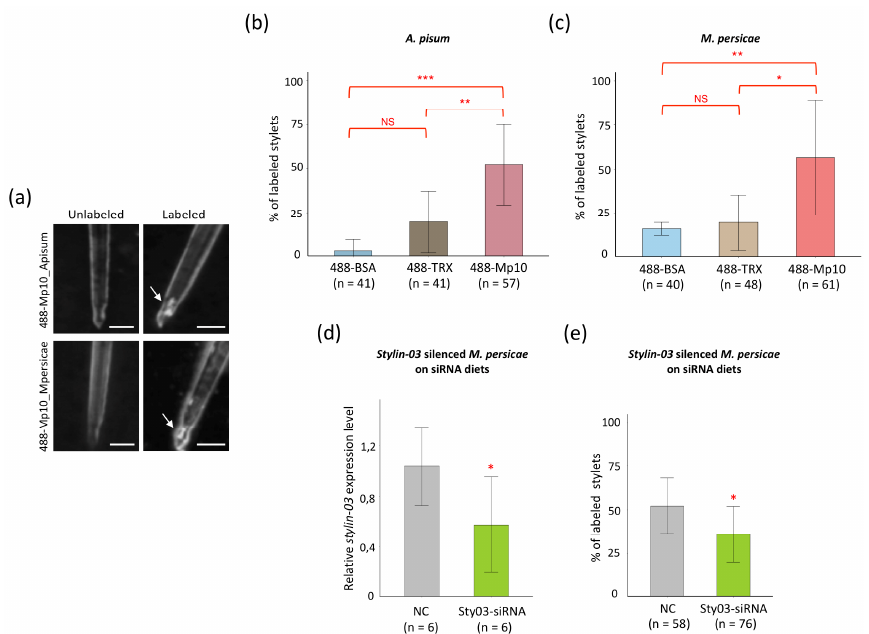
Figure 2. Mp10 directly binds to the acrostyle of dissected stylets. ( a ) Stylets of A. pisum and M. persicae , observed after incubation with 488-Mp10_Apisum and 488-Mp10_Mpersicae, respectively. Stylets were scored “labeled” when fluorescence was detected specifically at the apex of maxillary stylets, on the acrostyle (white arrow). Scale bars represent 5 µm. Proportion of A. pisum ( b ) or M. persicae ( c ) stylets showing fluorescence at the acrostyle area after incubation with Alexa Fluor 488 conjugates. Asterisks in ( b ) indicate a significant difference between 488-Mp10_Apisum and 488-BSA or 488-Mp10_Apisum and 488-TRX conditions (binomial GLM, Tukey tests, p < 1 × 10 − 3 and p = 4 × 10 − 3 , respectively). 488-BSA and 488-TRX conditions do not differ significantly